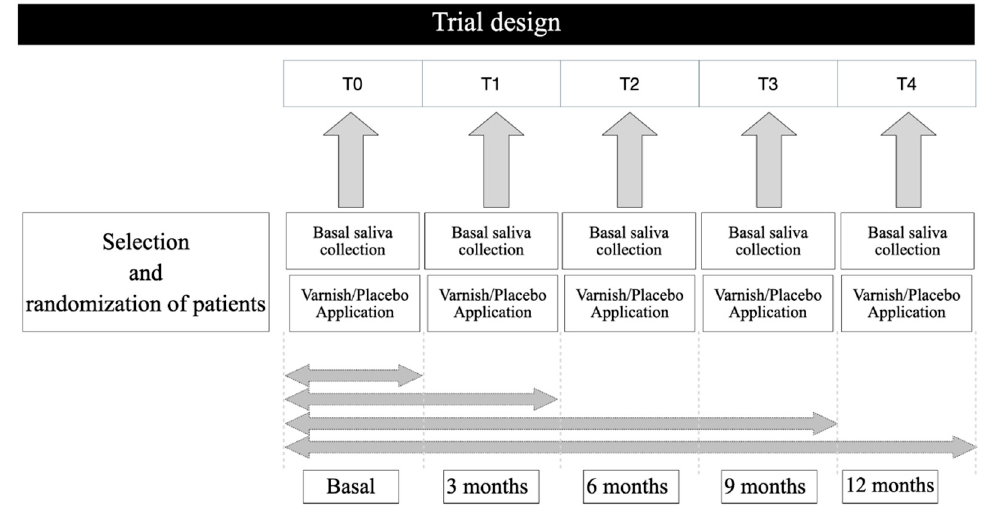
Figure 1. Clinical trial design.